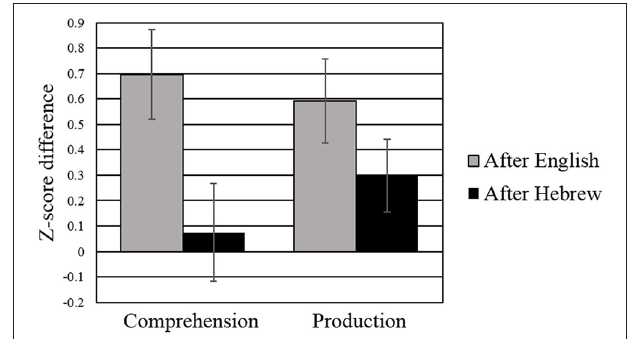
FIGURE 3 | Pre and post z -scores in the category fluency task (error bars represent standard